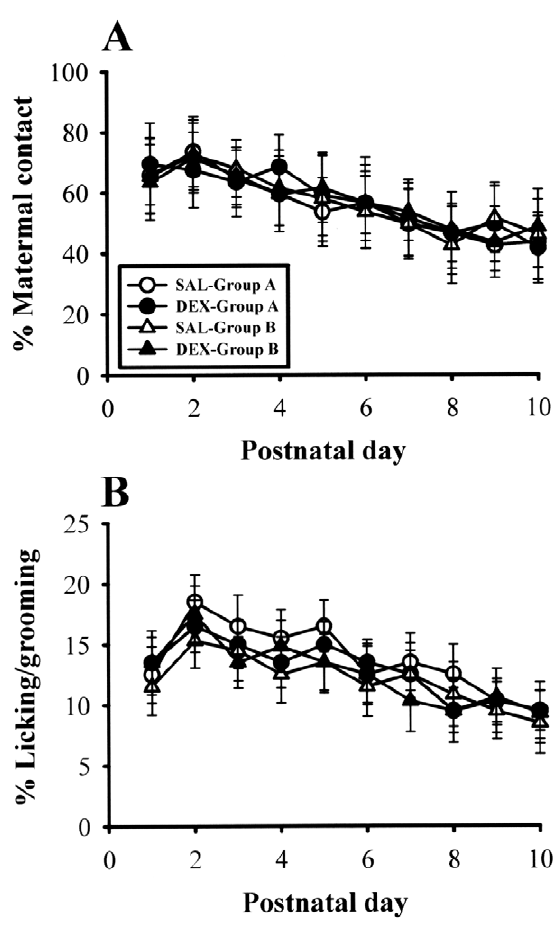
Figure 2. Effect of litter size on maternal care over the first 10 days postpartum. (A) Percentage of time spent in maternal contact (the total of all behavioral categories involving contact between dam and pups including licking/grooming, arched-back nursing, flat-back nursing, passive nursing) across days in neonatal SAL- and DEX-treated rat pups for Group A and Group B. (B) Percentage of time spent in maternal licking/grooming behavior across days in neonatal SAL- and DEX-treated rat pups for Group A and B. Data represent the mean 6 SEM (n=8 for each group).